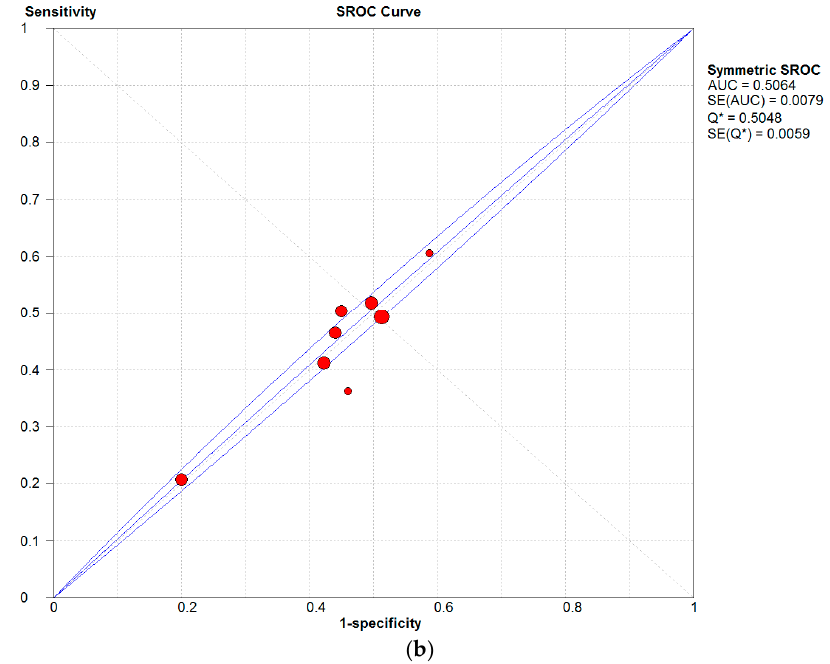
Figure 4. Summary receiver operating characteristic (SROC) curves of influences of ( a ) PM 2.5 , ( b ) PM 10 on human skin.